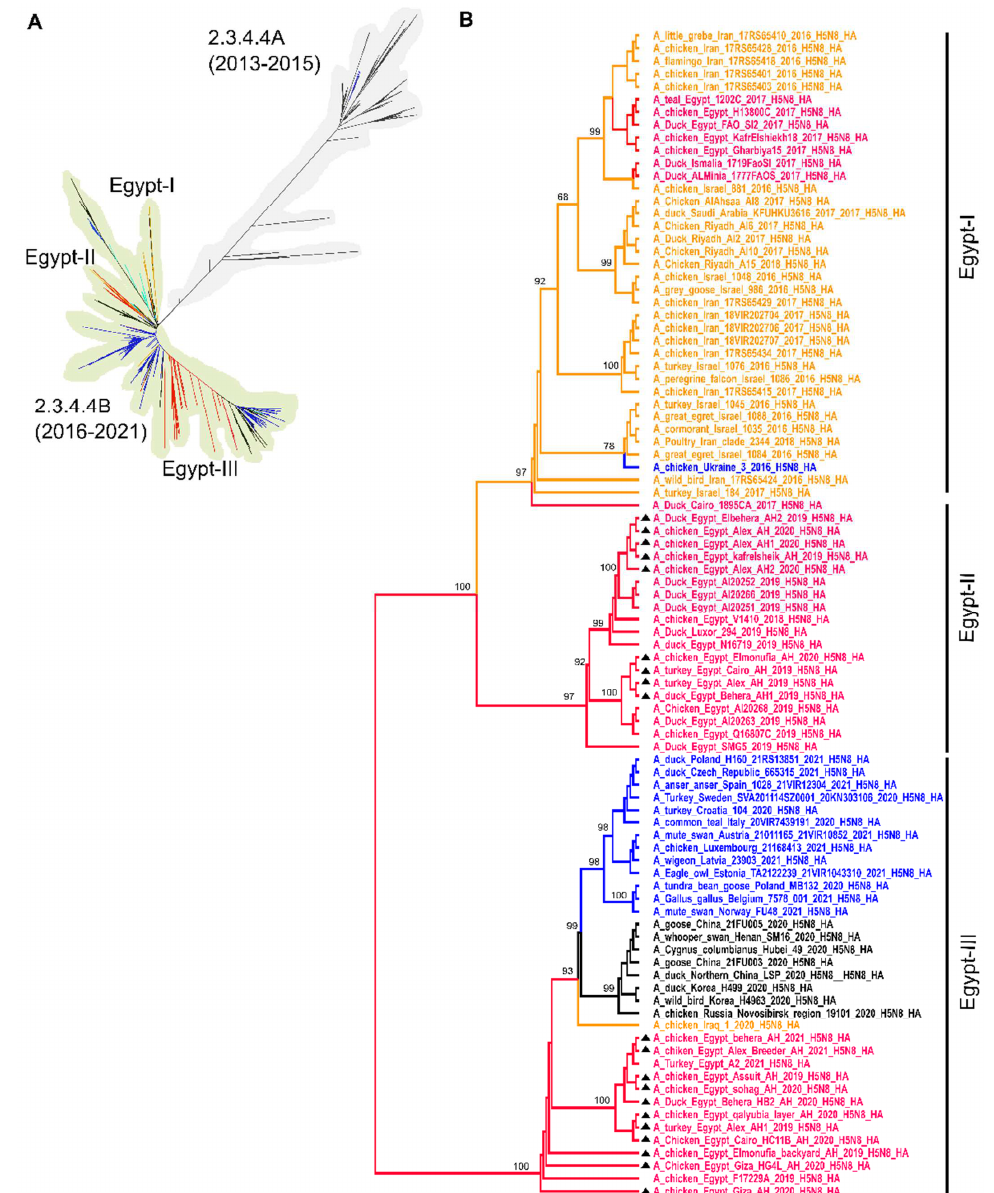
Figure 1. Phylogenetic relatedness of the HA of Egyptian H5N8 to Eurasian viruses. Nucleotide sequences of all-full or near-full HA ( n = 2700) genes of H5N8 viruses from Asia, Africa, the Middle East and Europe were retrieved on 21 January 2022 and aligned using MAFFT, and the tree was generated by IQTree. The tree shows clade 2.3.4.4a mainly circulated in wild birds and rarely in poultry from 2013 to 2015, and clade 2.3.4.4B viruses from 2016 to 2021 ( A ). The phylogenetic tree of the Egyptian H5N8 viruses in clade 2.3.4.4B, including new sequences generated in this study (marked in black triangles), and selected sequences from other countries was generated by MrBayes implemented in Topali v.2 using the GTR + G model. Trees were generated after selecting 4 chains of 10,000,000 replicates and 25% buried-in parameters. Posterior probability values are shown on the main nodes ( B ). Egyptian H5N8 sequences are shown in red, H5N8 sequences from the Middle East are shown in orange, sequences from Europe are shown in blue and Asian viruses are in black. Branches depicted in cyan in panel A refer to sequences from other African